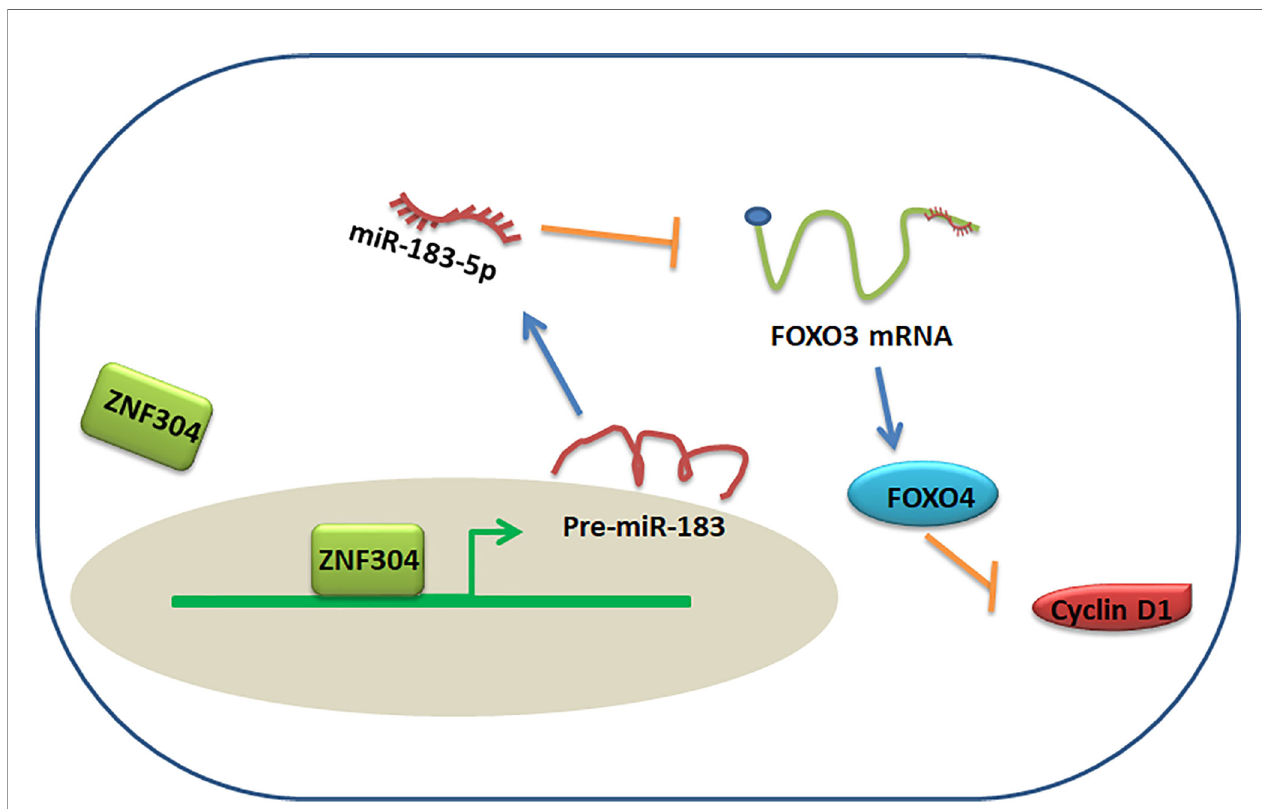
FIGURE 7 | Proposed model for ZNF304/miR-183-5p/FOXO4 regulation of ccRCC